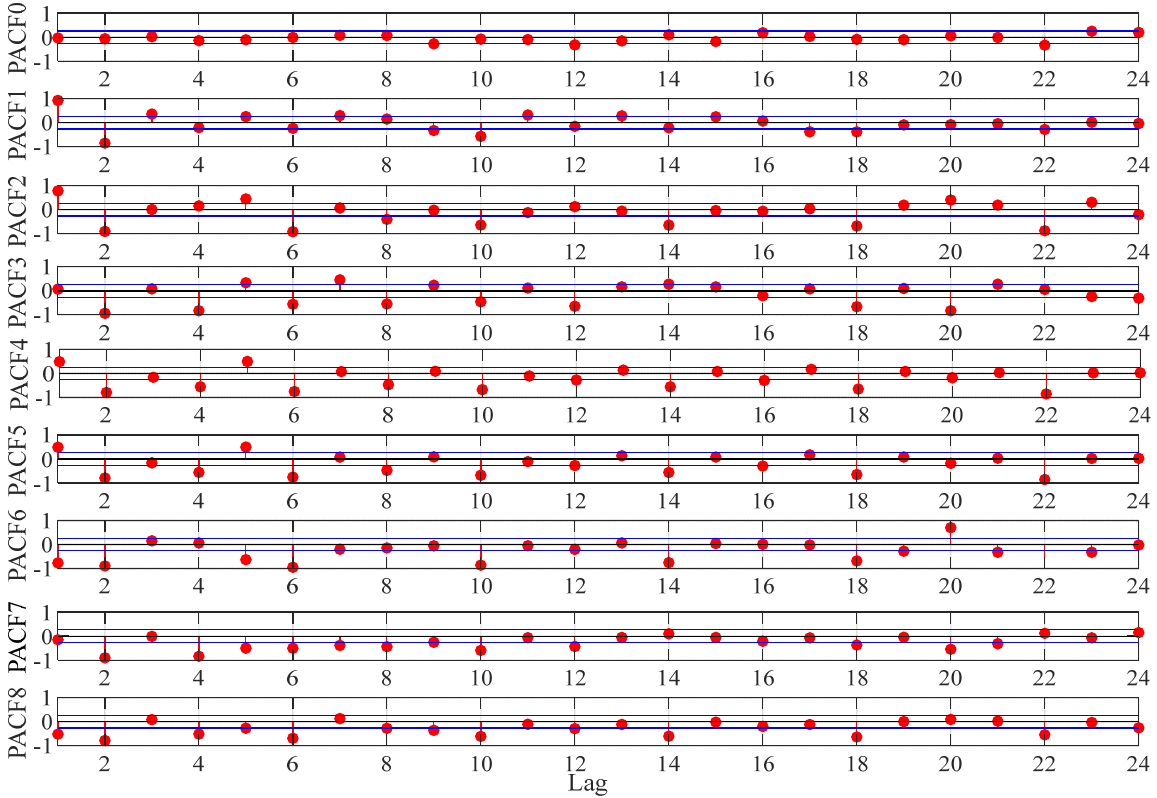
Figure 6. Partial autocorrelation function (PACF) values for different series.